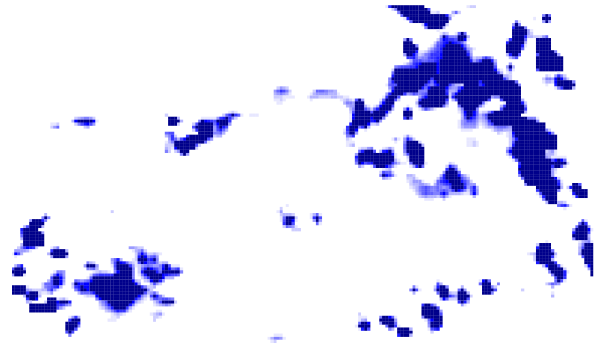
Figure 3. Example of rain data in GeoTIFF format for Europe a large number of cars all over the world. Due to privacy